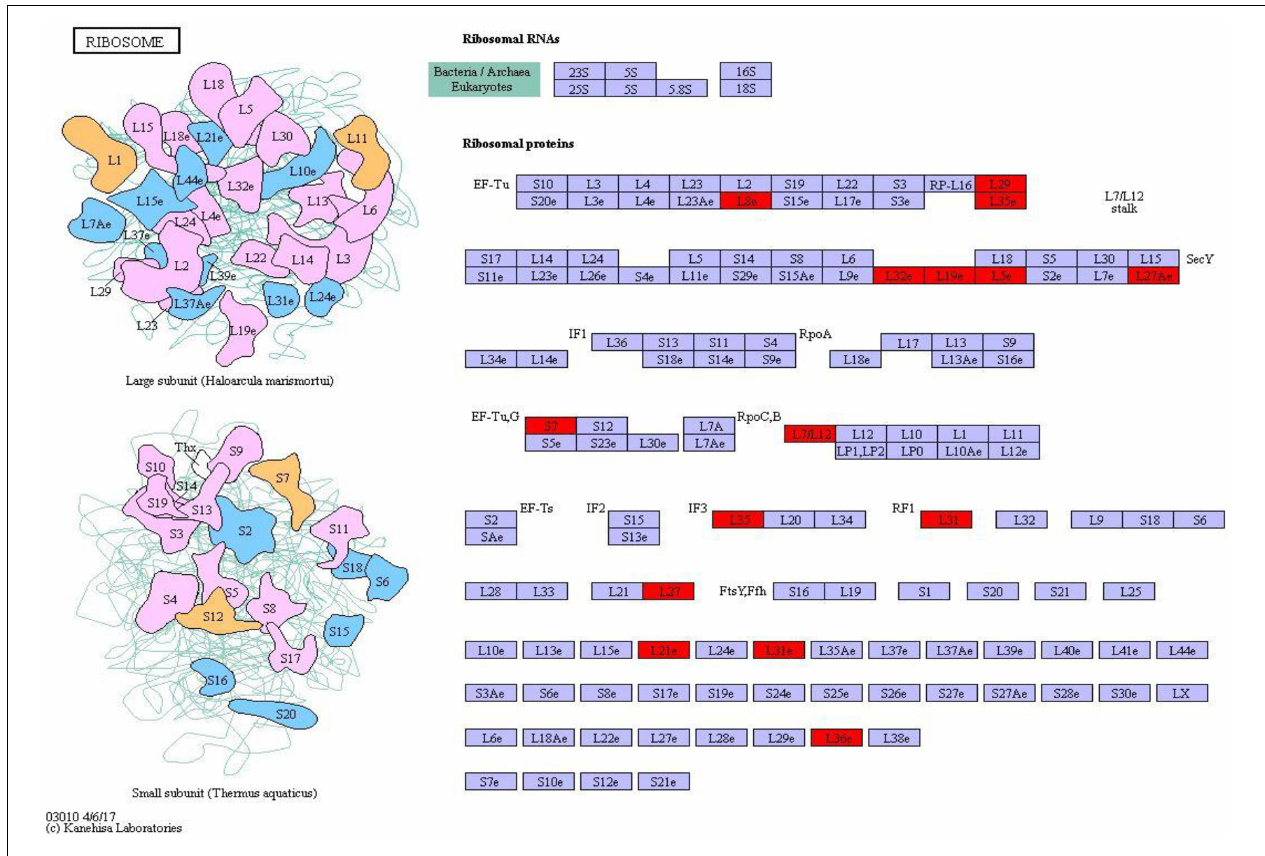
FIGURE 8 | Ribosome pathway and differential protein expression. The red box indicates upregulation of differentially expressed proteins.